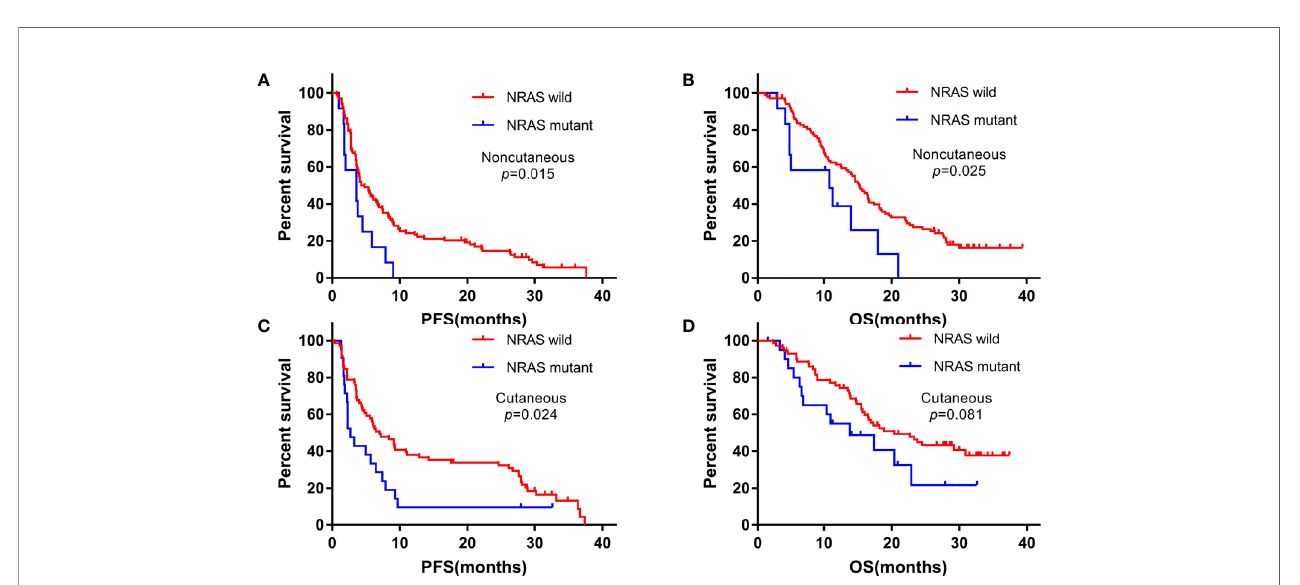
FIGURE 1 | Kaplan-Meier curves for progression-free survival (PFS) and overall survival (OS) among patients with NRAS mutant and wild-type statuses treated with anti-PD-1 monotherapy. (A, B) noncutaneous melanoma; (C, D) cutaneous